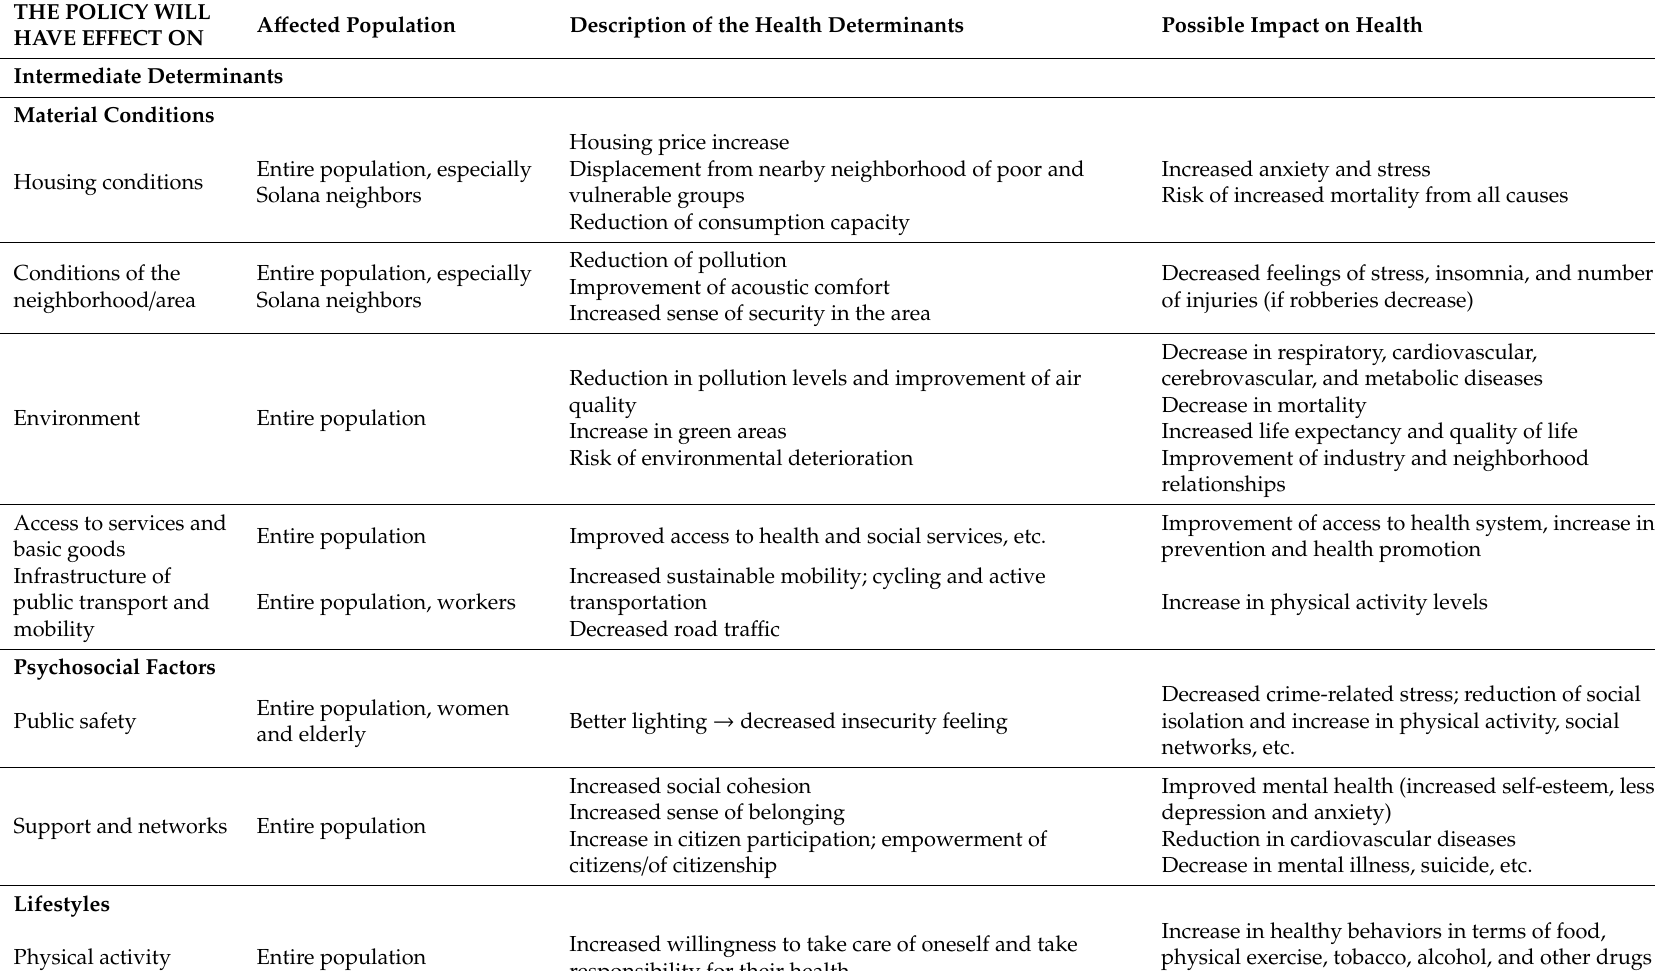
Table 1. Potential e ff ect on health, health determinants, and heath